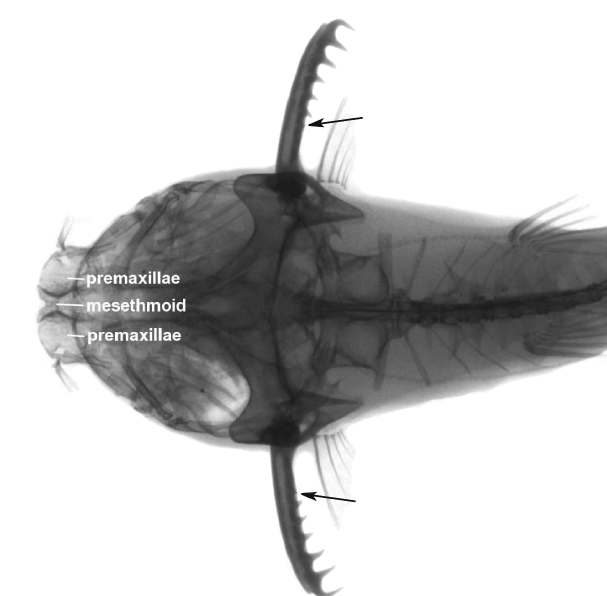
Fig. 3. Radiograph of anterior region of Xyliphius anachoretes , MNRJ 31923, holotype, 88.4 mm SL, showing premaxilla lateral to mesethmoid, and completely separated from its pair. Arrows showing rudimentary serrae on pectoral spines.